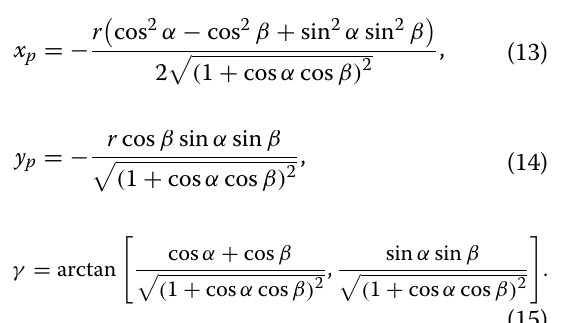
According to Figure 4, the closed-loop equation 1 of limb 1 can be obtained, as shown in Eq.